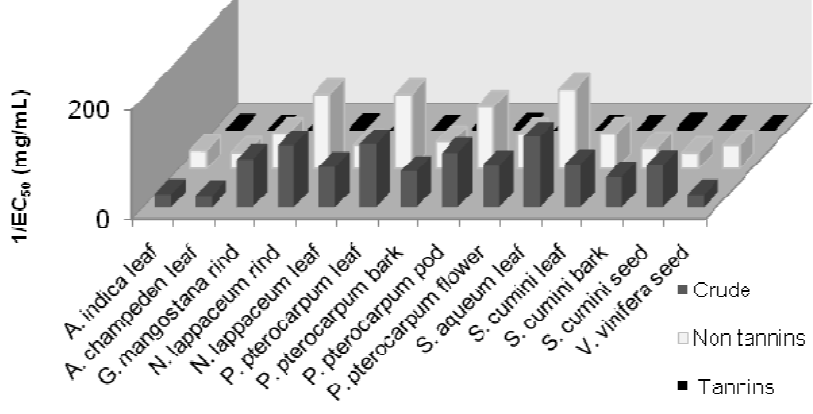
Figure 4.  -Glucosidase inhibition activity in the crude, non-tannin, and tannin extracts of various